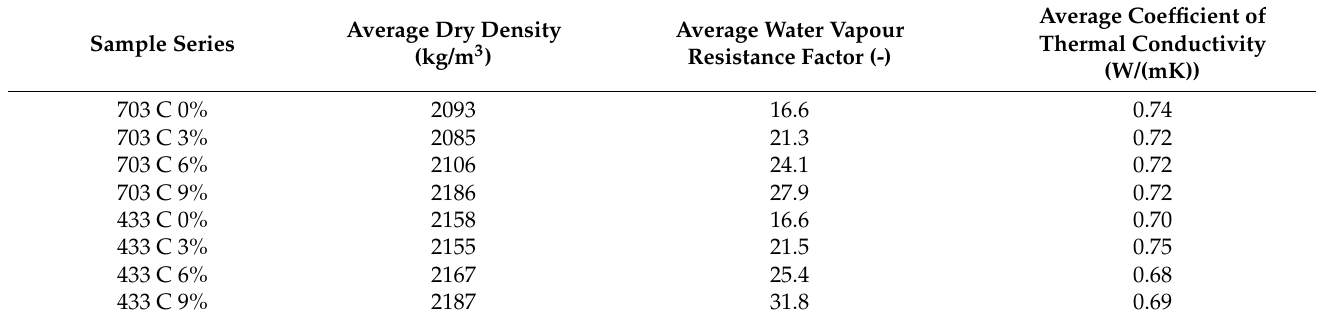
Table 4. Comparison of the results of heat conduction and diffusion resistance for the tested CSRE series.